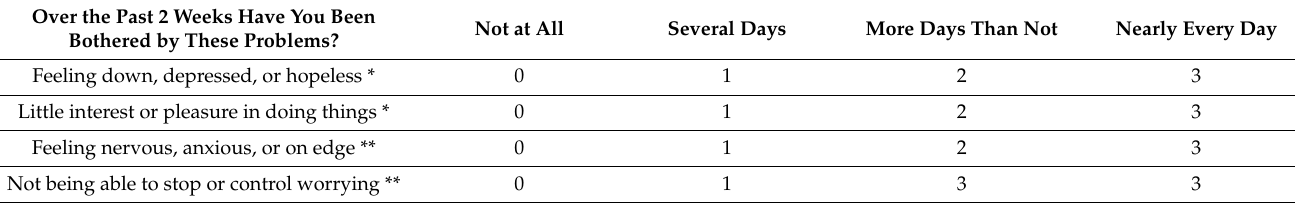
Table A1. The 4-item Patient Health Questionnaire (PHQ-4).